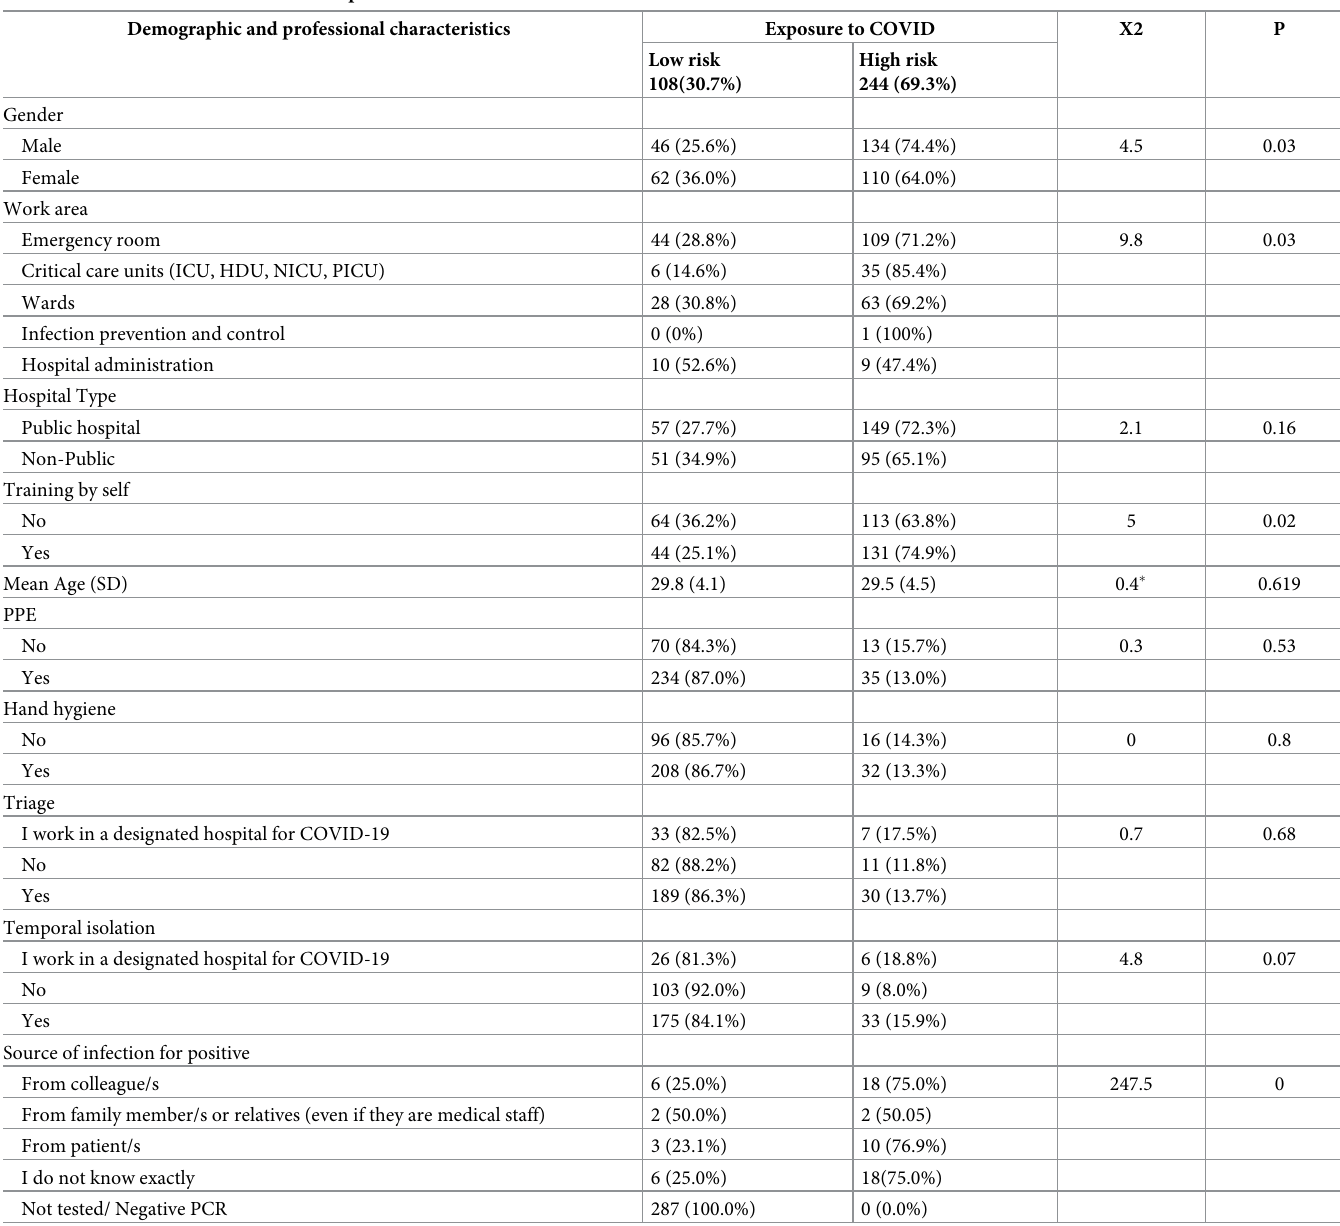
Table 3. Factors associated with risk of exposure to